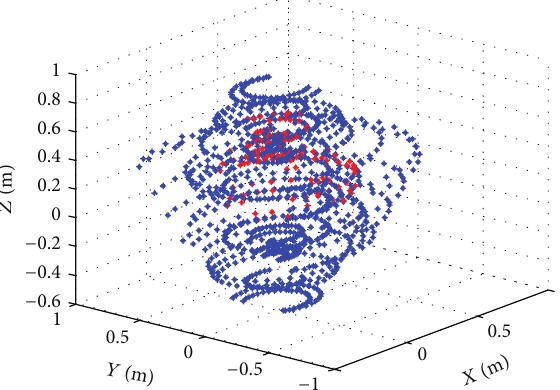
Figure 13: Attainable space and mission attitude